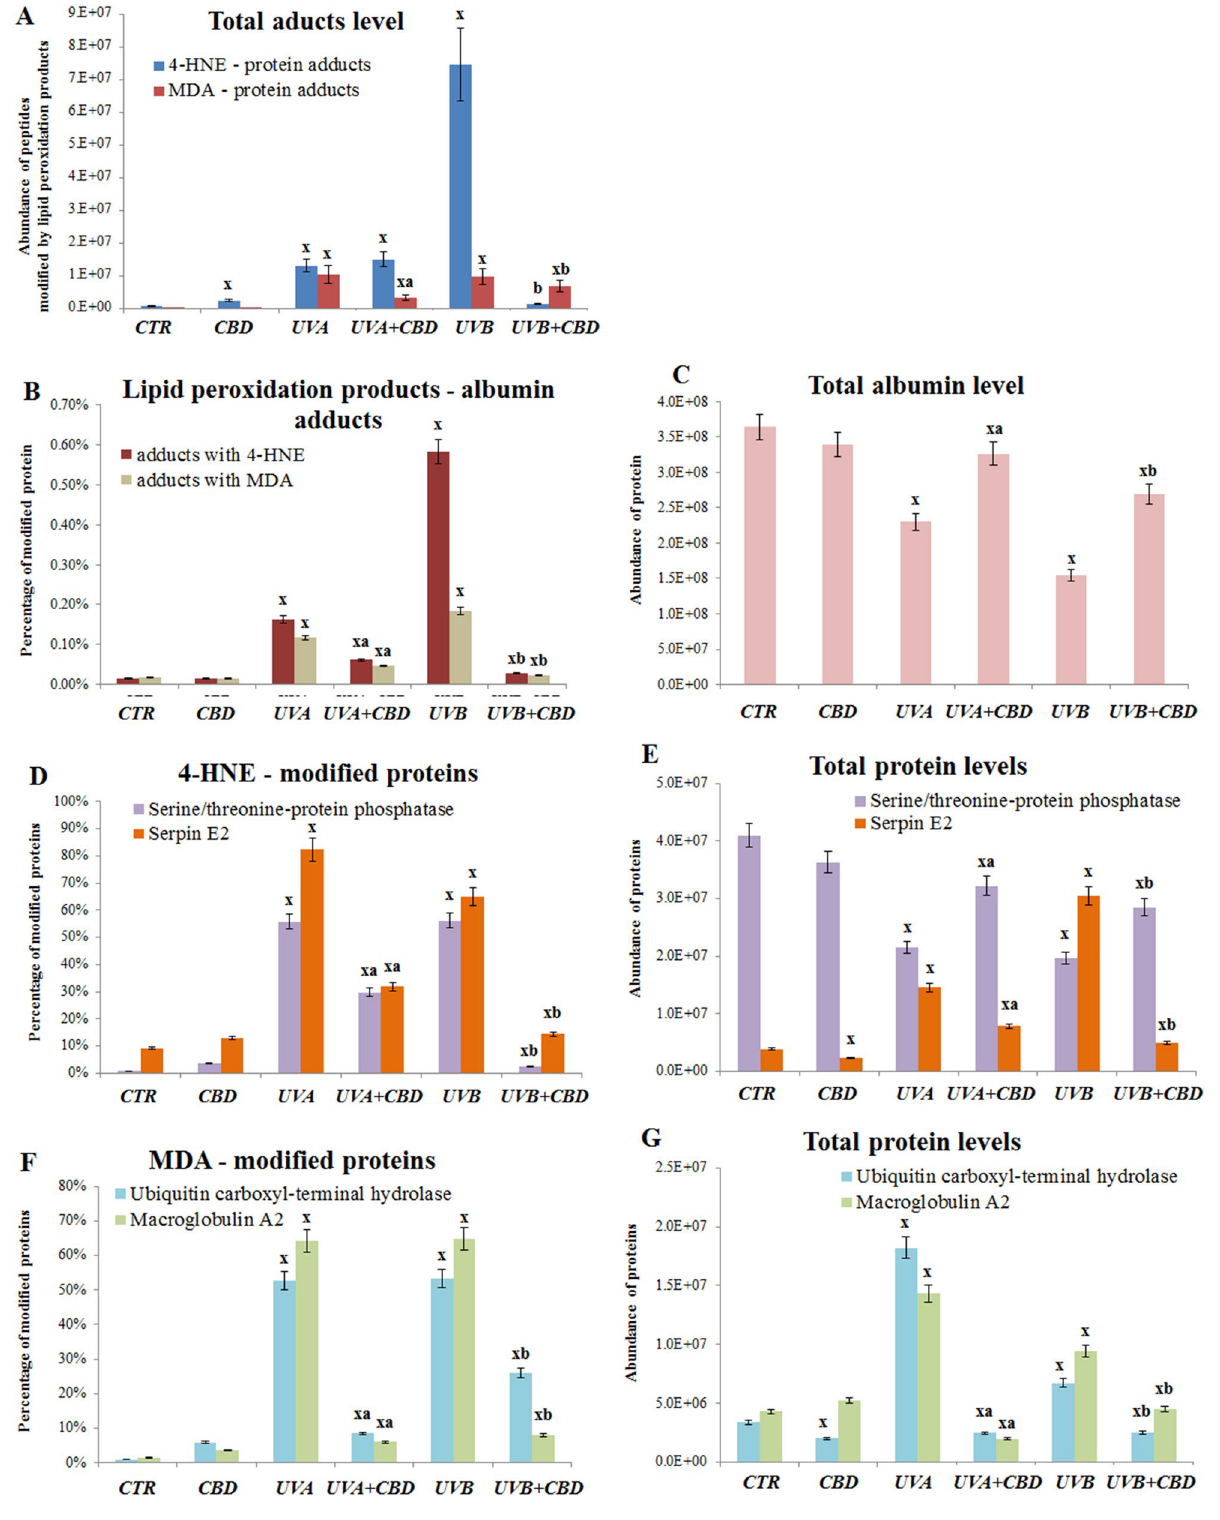
Figure 4. The level of lipid peroxidation products—proteins adducts in plasma from the control rats (CTR) and animals topically treated with cannabidiol (2.5 g CBD in 100 g petrolatum) and/or irradiated with UVA (increasing doses from 0.5 to 5 J/cm 2 ) or UVB (increasing doses from 0.02 to 2 J/cm 2 ). Individual diagrams show total level of adducts ( A ), level of albumin and its modifications ( B, C ), and levels of mostly modified proteins by 4-HNE ( D, E ) and MDA ( F, G ). Mean values ± SD of six independent experiments are presented. x Statistically significant differences vs. CTR group, p < 0.05; a Statistically significant differences versus UVA irradiated group, p < 0.05; b Statistically significant differences versus UVB irradiated group, p <